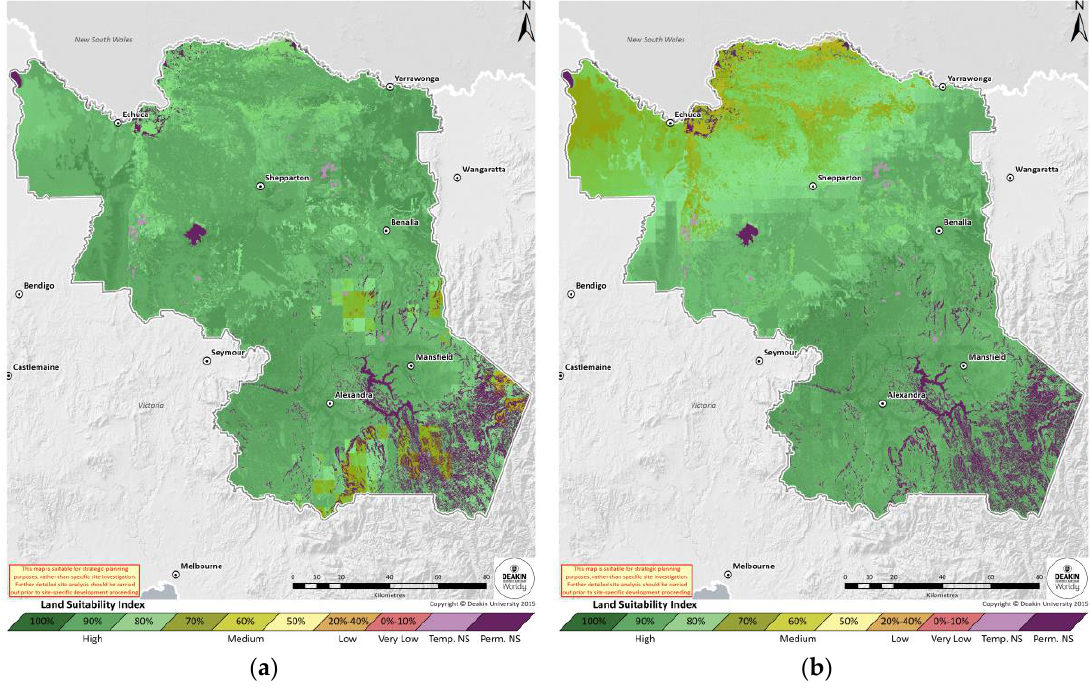
Figure 7. Nested Analytical Hierarchy Process Fuzzy Set Membership model for ( a ) climate normal ( b ) 2050.